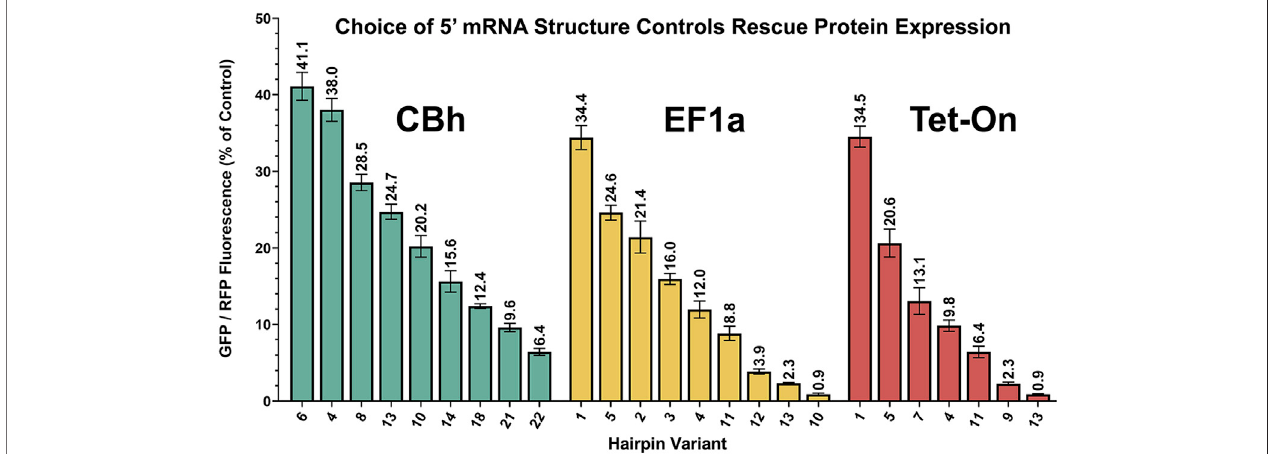
FIGURE 3 | Performance-ranked collection of select hairpins. Scalable translation in Knockdown-Replacement vectors allows endogenous expression matching when employed with constructs in Figure 1 . Pictured are a core subset of constructs from Figure 2E , ranked by performance rather than thermal stability, and normalized to the brightest average RFP signal from the EF1a promoter. Modular selection of hairpin structure controls protein translation, permitting physiological matching of “ rescue ” gene expression to endogenous levels. All of these plasmids (9 CBh, 9 EF1a, 7 Tet-On) are deposited with Addgene.